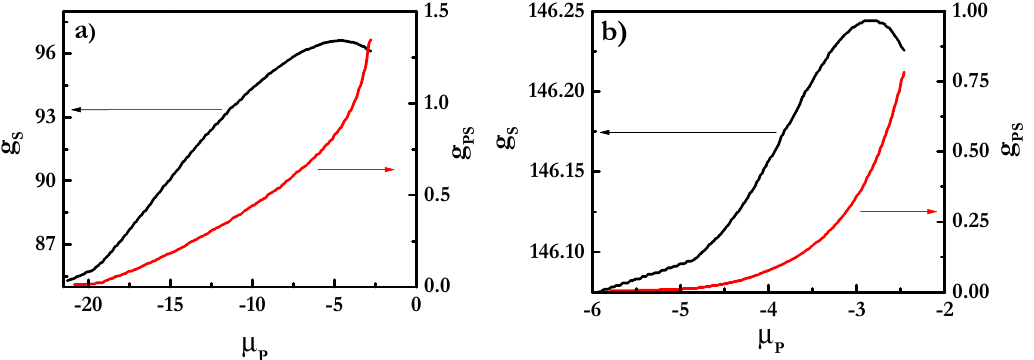
Figure 2. ( a ) Scheme representing the model assumed for Self-Consistent Mean-Field Calculations (SCF) calculations. ( b ) Scenario for those systems in which micelles bridge several polymer chains (formation of multichain complexes, g PS > 1). ( c ) Scenario for those systems in which micelles do not bridge polymer chains ( g PS < 1).